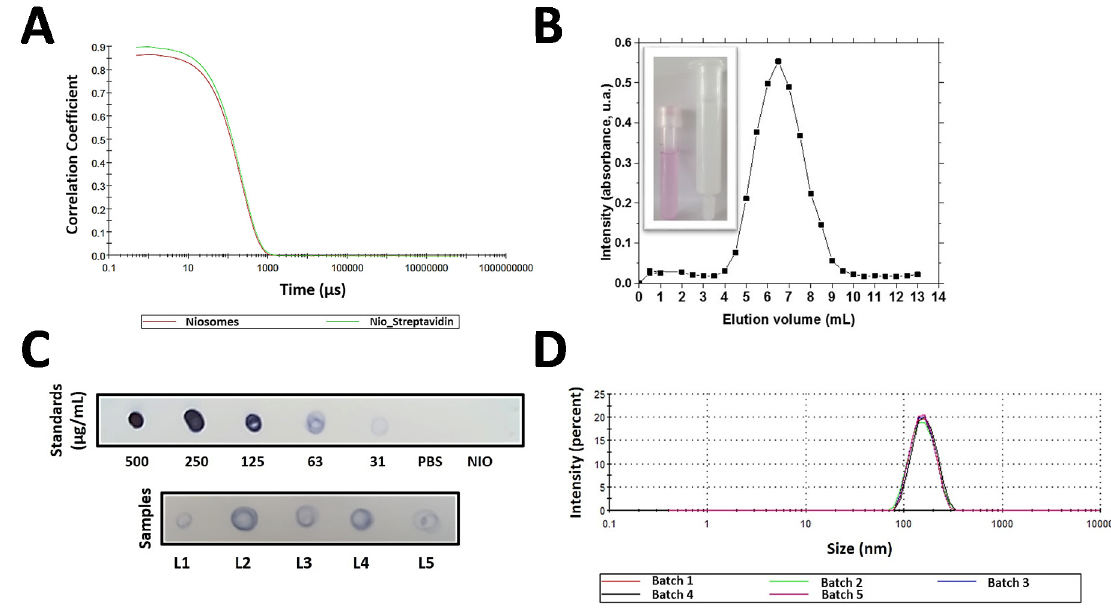
Figure 2. ( A ) Autocorrelation data from dynamic light scattering (DLS) measurements for a sample of uncoated niosomes, red curve, and niosomes with streptavidin, or Nio_Str, green curve. ( B ) Elution profile of a solution of streptavidin from a Sepharose CL-4B size exclusion chromatography (SEC) gravity elution column. Signal quantification of each 0.5 mL fraction was measured by bicinchoninic acid assay (BCA) total protein assay according with manufacturer instruction. Insight (left) shows the first 3.5 mL collected of a suspension of red dye loaded niosomes to allow their visualization, after their elution from the SEC column; (right,) the SEC column after the elution of the 3.5 mL of dyed niosomes. Both elements, niosomes and free protein, eluted from the column enough separate to allow their separation based on Sepharose CL-4B gravity elution columns. ( C ) Dot-blot assay for checking the effectively of streptavidin bioconjugation to niosomes through carbodiimide method (EDC/NHS). Standards of different concentrations allow the semiquantification of the process by comparison of spot intensity. The result shows the 5 different batches. Biotinylated-HRP (4 µg/mL) was used as detecting agent. ( D ) Size distribution by DLS of the 5 different batches of Nio_Str (152 ± 2 nm in diameter), to demonstrate the reproducibility of the preparation process.